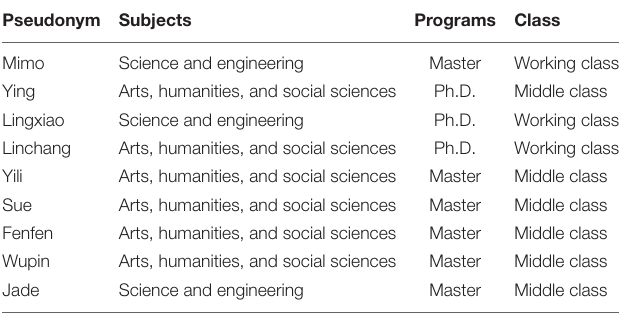
TABLE 2 | Profile of informal interview cases from participant